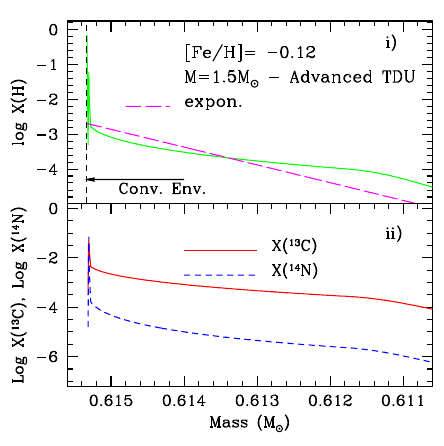
Figure 1. Upper panel: the reservoir (often called pocket ) of protons mixed from the envelope, as a consequence of magnetic buoyancy computed according to [10, 11]. Lower panel: the ensuing distri- bution of 13 C and 14 N, established after burning is restarted in the H shell . As indicated in the label, the plot refers to an intermediate evolutionary stage of a 1.5 M (cid:12) Thermall-Pulsing ( TP ) AGB star of almost solar metallicity